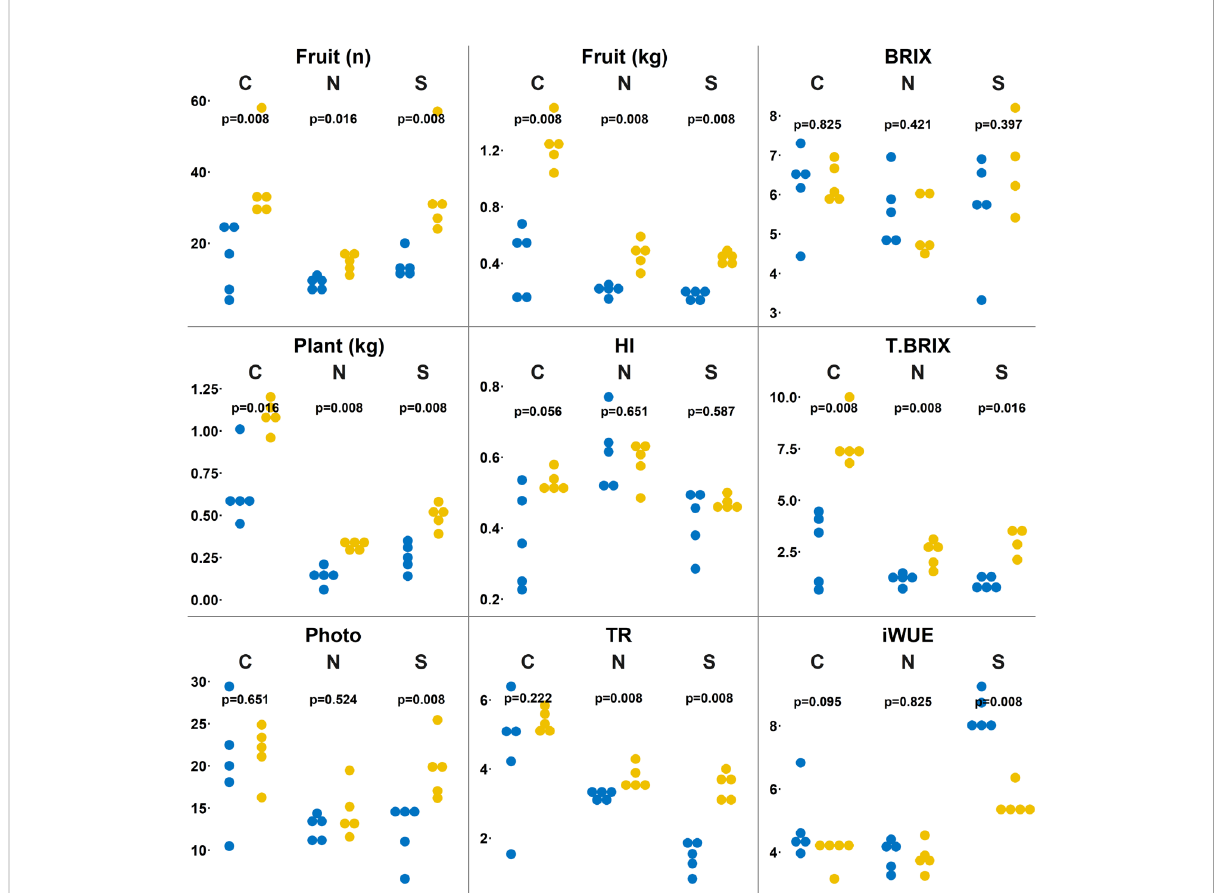
FIGURE 2 Physiological comparison between solarized and biosolarized pretreated plants. Boxplots of number of fruit (n), plant fresh biomass (kg), fruit weight (kg), harvest index in proportion of fruit weight out of total weight (HI), sugar content (BRIX), Total sugar content as the product of fruit weight and sugar content (T.BRIX), Leaf gas exchange analysis as carbon dioxide assimilated (Photo), transpiration as water transpired over time and space (Tr), instantaneous water use ef fi ciency (iWUE) comparing solarized (SOL) and biosolarized (BIO) pretreated plants under well- watered (C), nitrogen-deprived (N) and salinity-treated (S) (n=4-5) plants. Signi fi cance was tested using the permuted Brunner Munzel test, presenting the